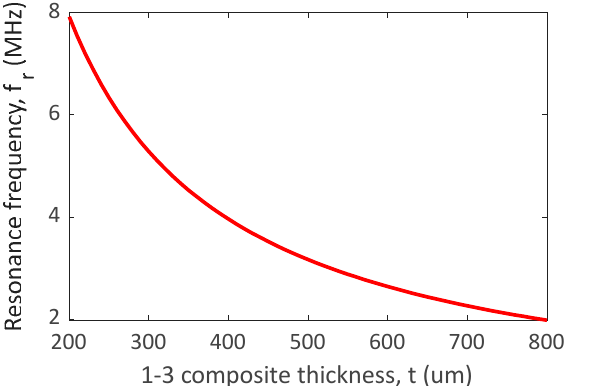
Figure 3. Prediction of the resonance frequency in the thickness vibration mode of the 1–3 piezoelectric composite transducer. Table 1. Material properties in the numerical simulation [14,29,37].